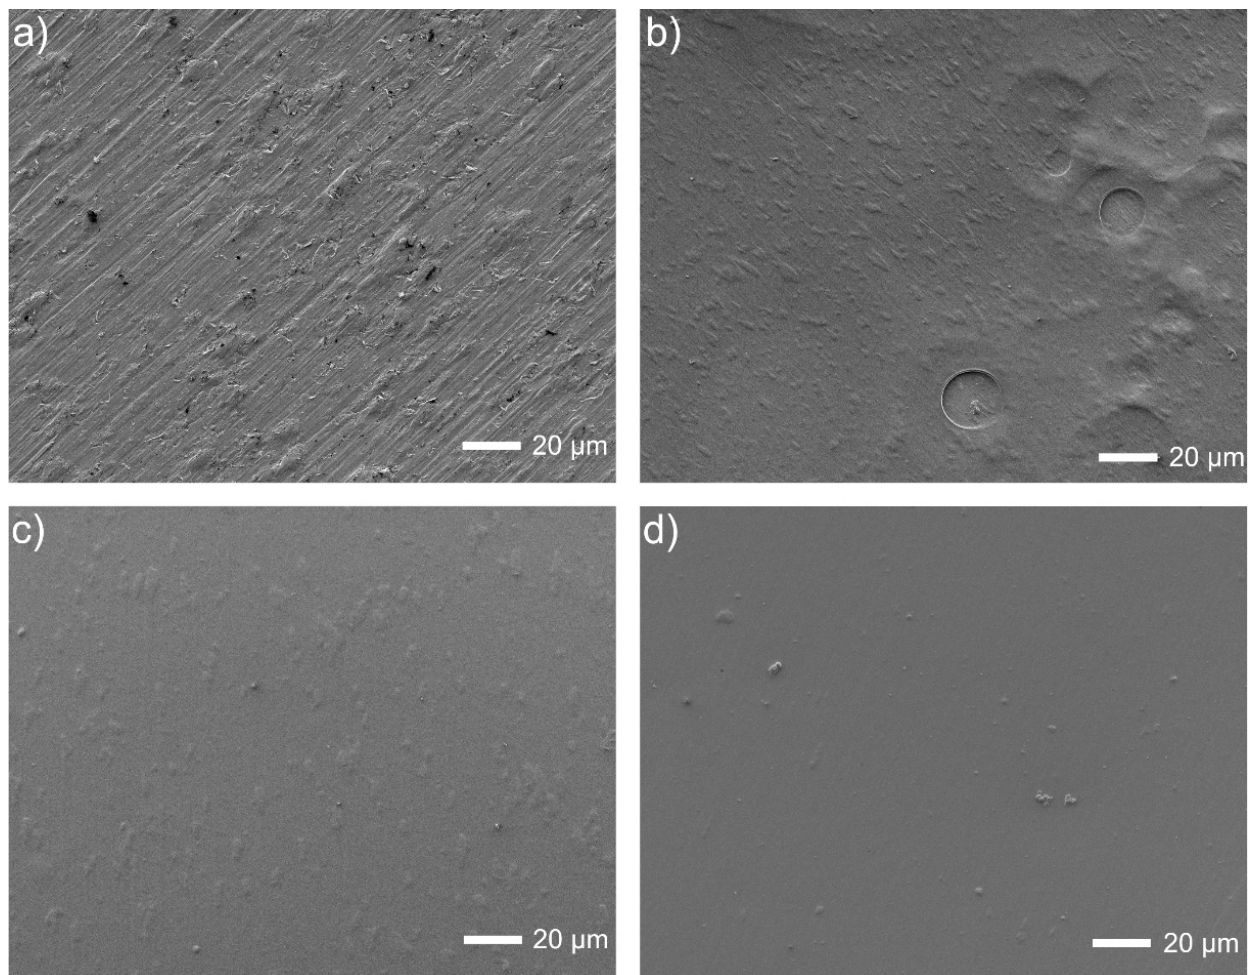
Figure 5. Microstructures of Ti13Nb13Zr surfaces: ( a ) ground, ( b ) ground and chitosan-coated, ( c ) ground and chitosan/Tween 20 coated, ( d ) ground and chitosan/Tween 20/nanoPt coated.